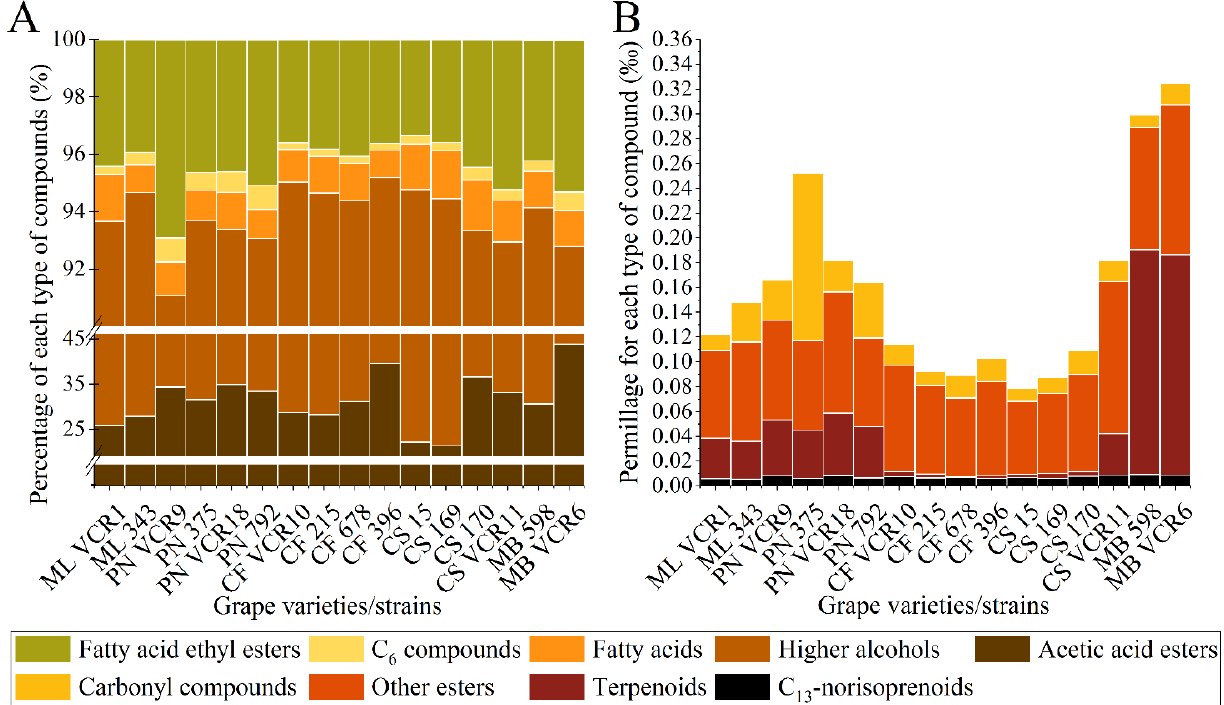
Figure 1. Proportions of various aroma substances in wine samples. ( A ) Percentage share of each type of aroma having high content. ( B ) Percentage of thousand points for some of the lower content aromas.